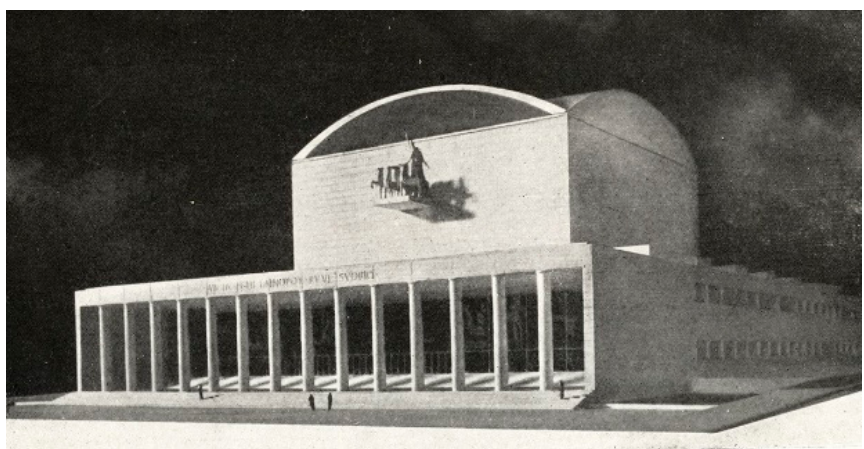
Figure 18 . Casa del fascio by Giuseppe Terragni. Como (1932–1936). The terrace. Photo from (Sartoris 1941, p. 399).